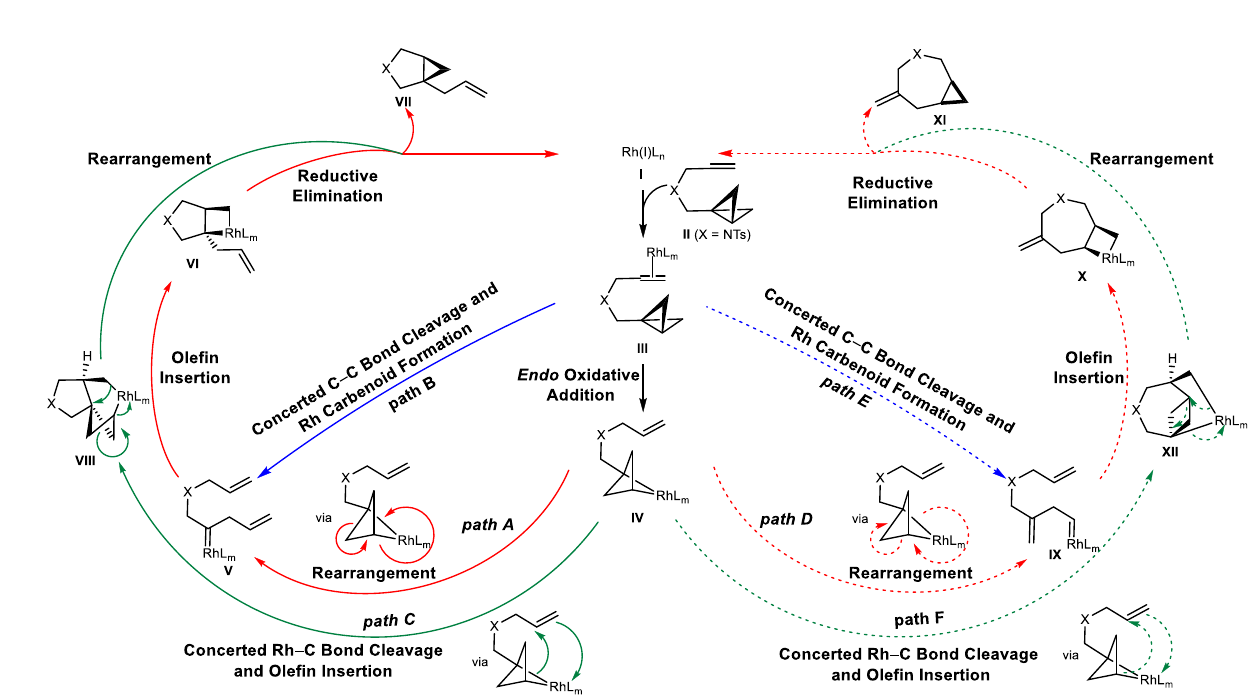
Fig. 2 | Neutral mechanisms for Rh(I)/PPh 3 -catalyzed cycloisomerization of bicyclo[1.1.0]butane. Starting from the active catalyst I , six different catalytic cycles(pathAtopathF)wereproposedtoform fi ve-( VII )orseven-membered( XI ) product.PathsA,B,andCleadtotheformationof VII ,andpathsD,EandFgiverise